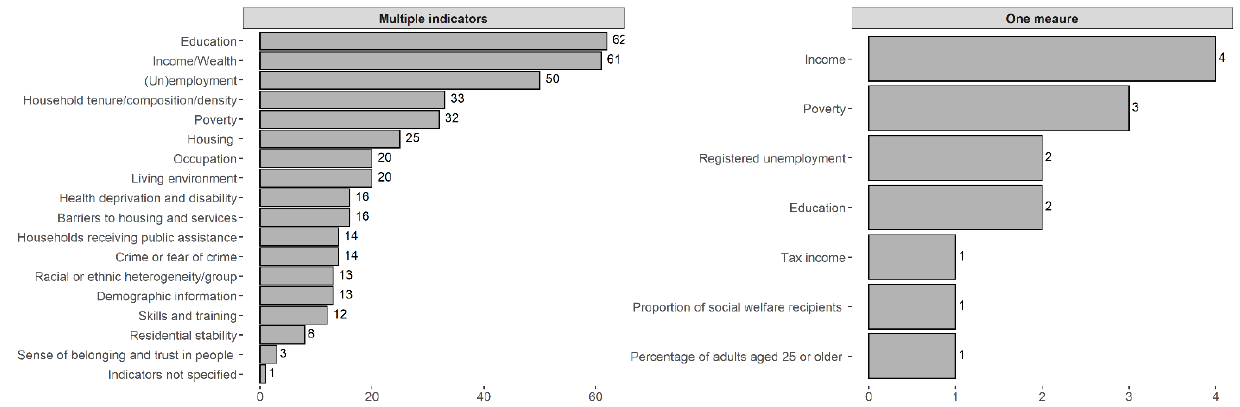
Figure 4. Distribution of the indicators used to measure neighbourhood socioeconomic deprivation.